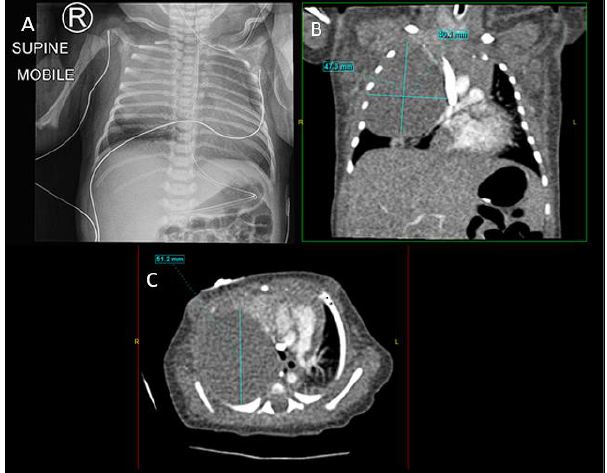
Figure 2: (A) Chest X-ray of Case 2 on Day 1 of life showing a homogenous opacification of the right middle and upper